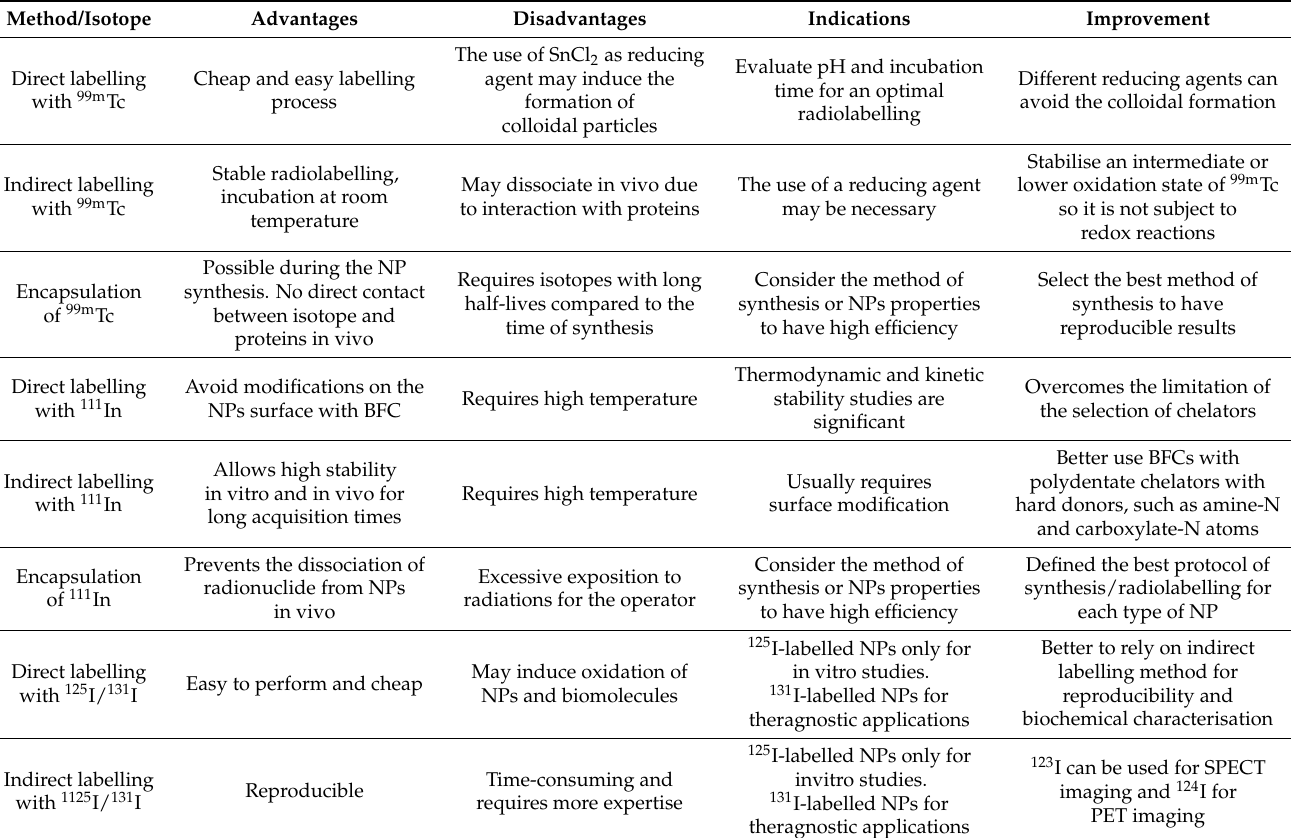
Table 1. Pros and cons of different methods for radiolabelling